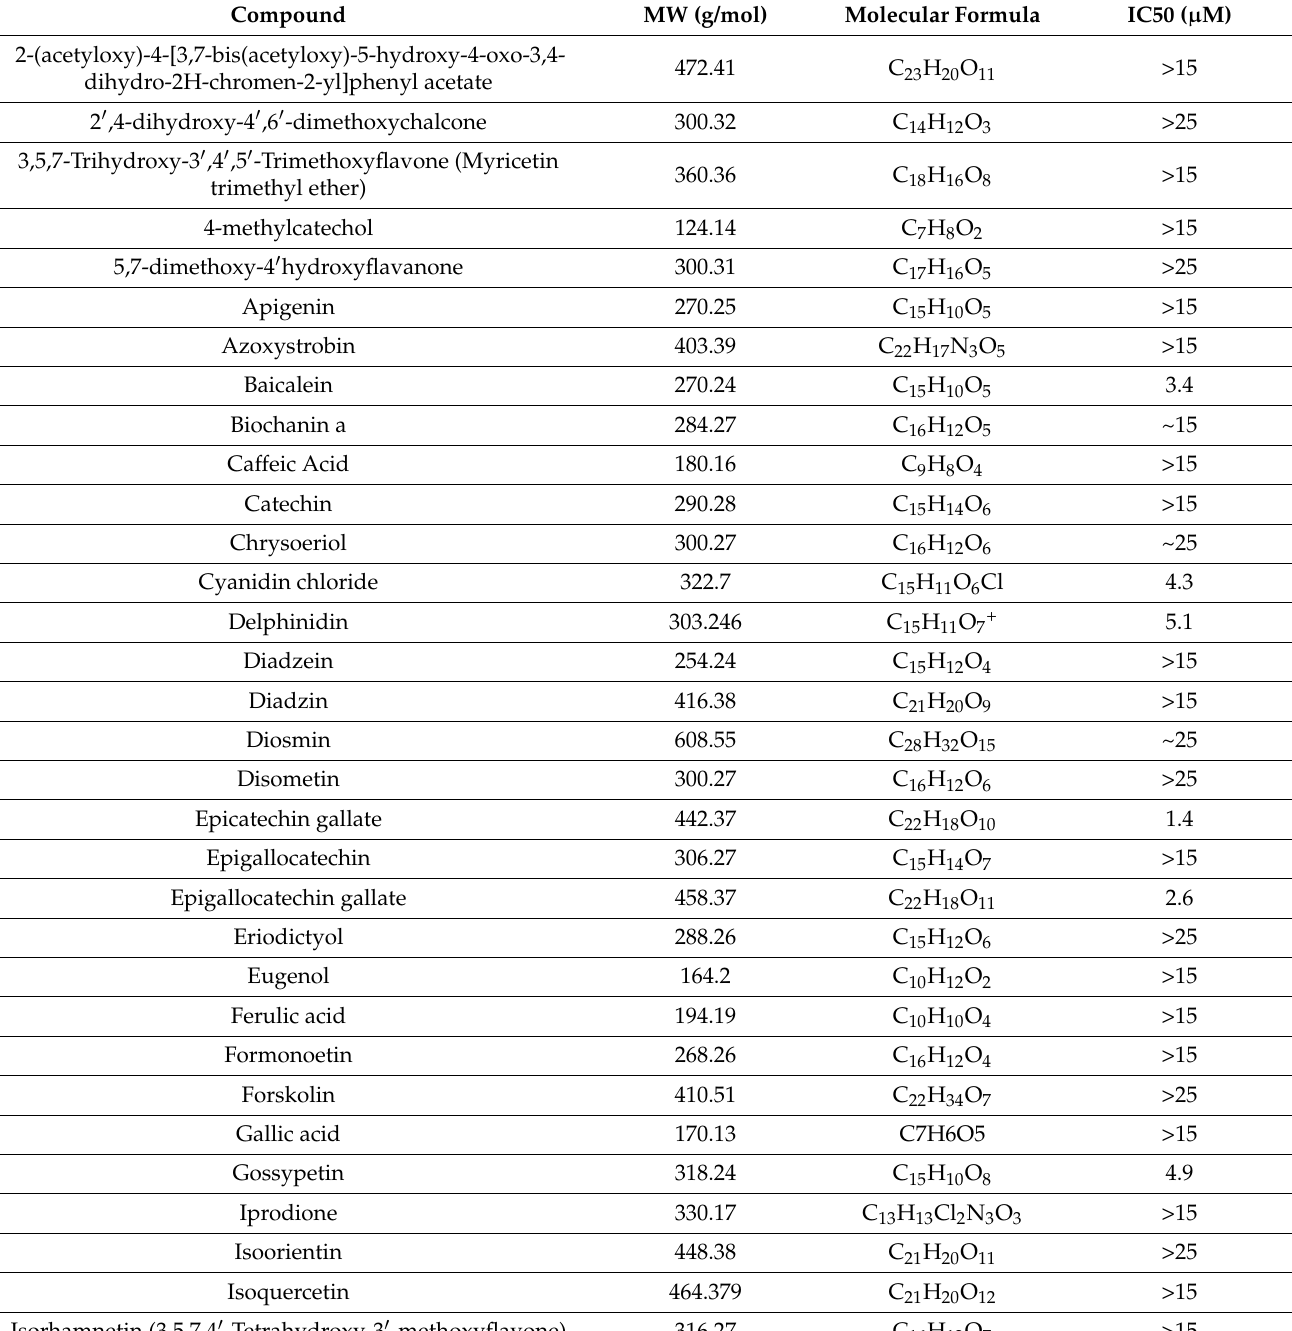
Table 2. Summary results of GSE flavonoids in PP2A demethylation activity assay.